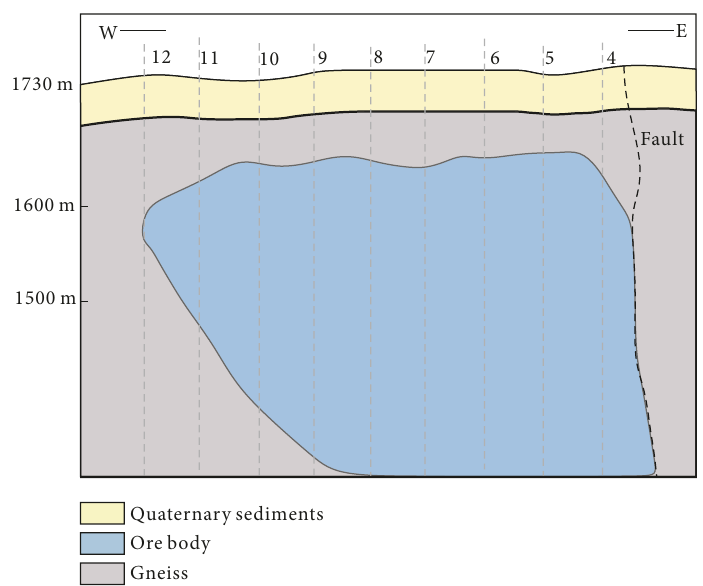
Figure 2: The longitudinal projection map of the 1 # ore body.